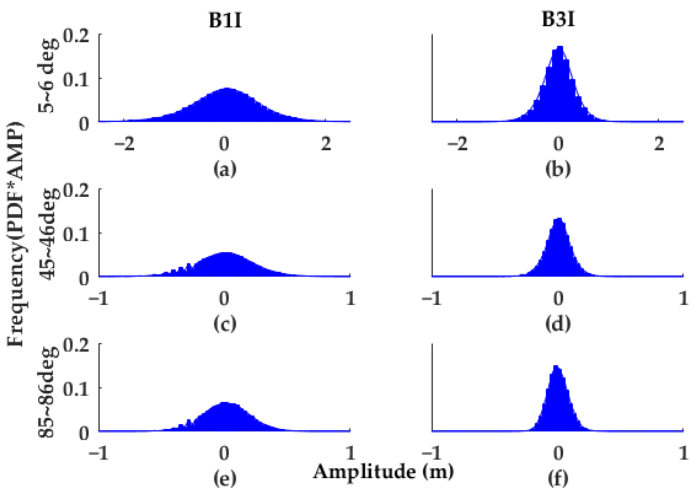
Figure 2. Distribution of multipath error at three elevation bins. The sub-figures ( a , c , e ) are distributions of B1I and ( b , d , f ) are distributions of B3I, respectively. The symbol “*” means “multiply”.